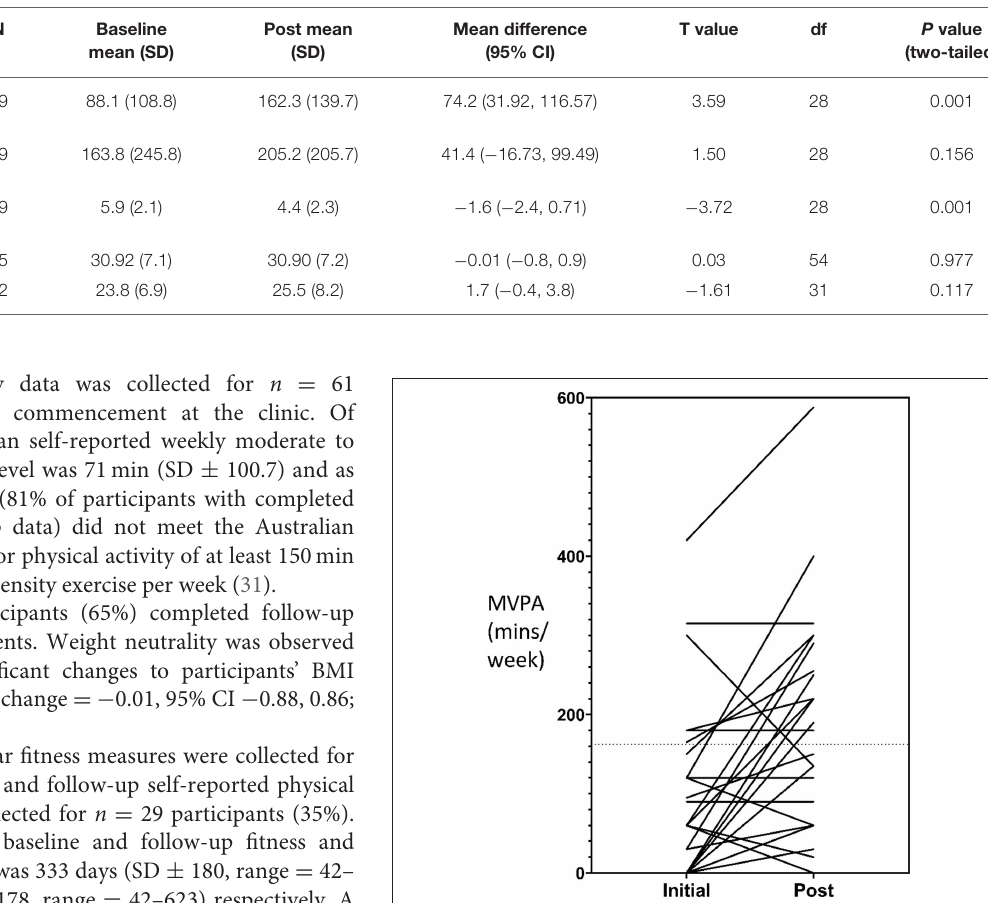
FIGURE 1 | Moderate-vigorous physical activity pre- and